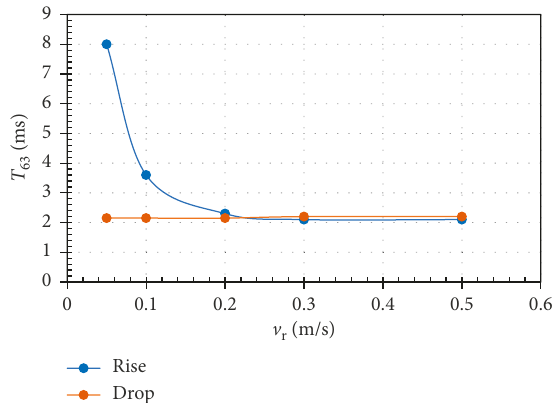
Figure 32: Influence of piston velocity on the primary response time for the rise and drop control